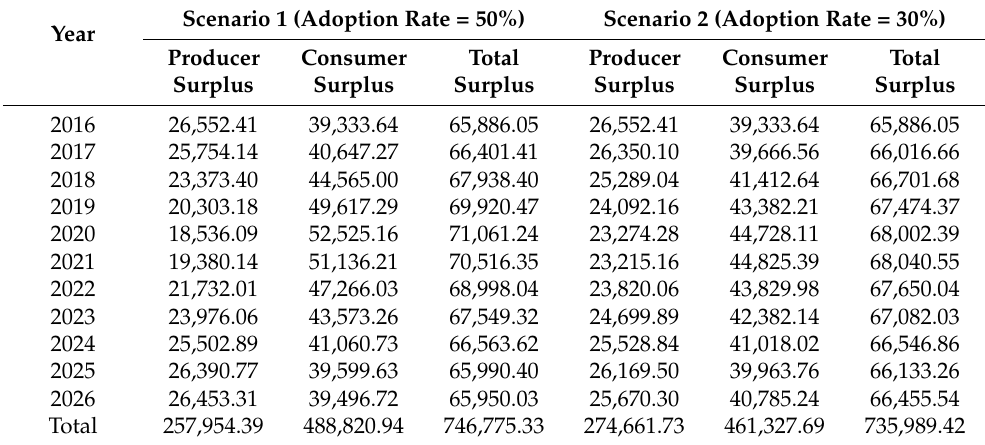
Table 4. Economic benefits of honeybee pollination under two scenarios (ten thousand